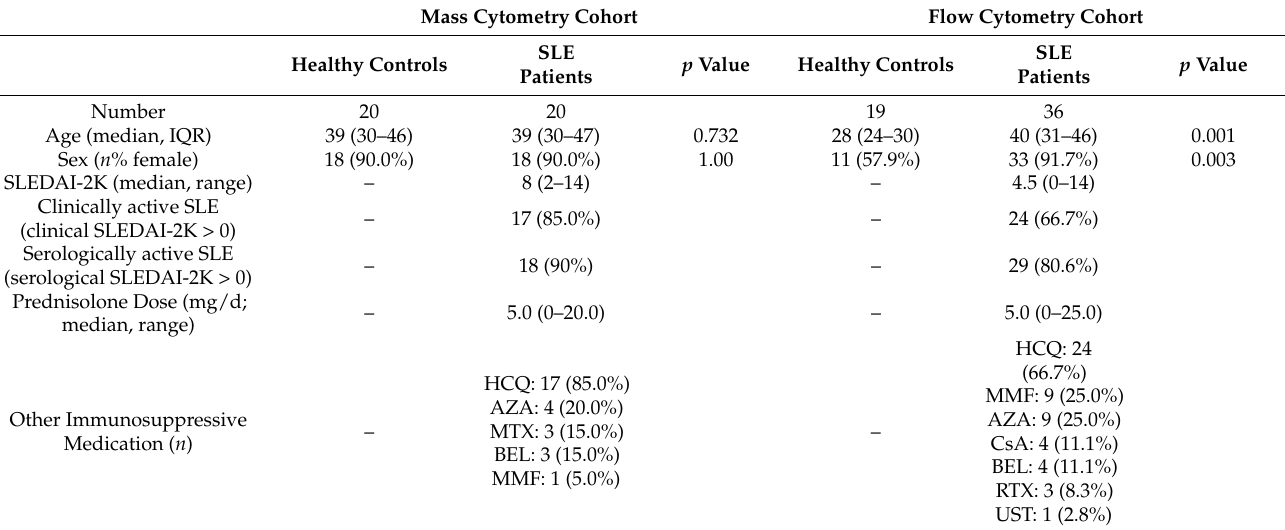
Table 1. Patient